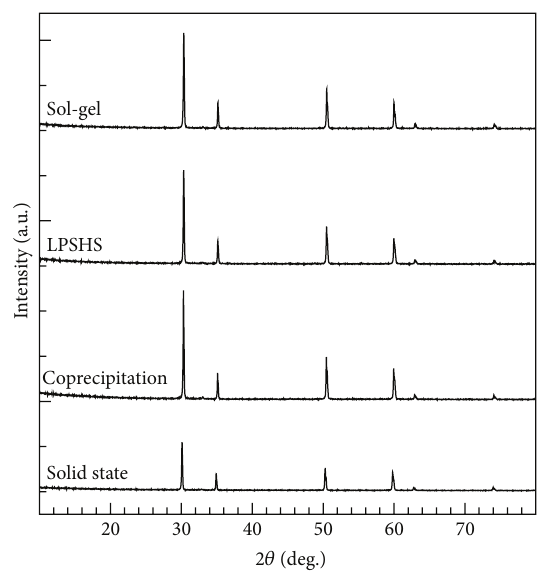
Figure 2: Postcalcination XRD for MnFe 2 O 4 samples created using four different synthesis